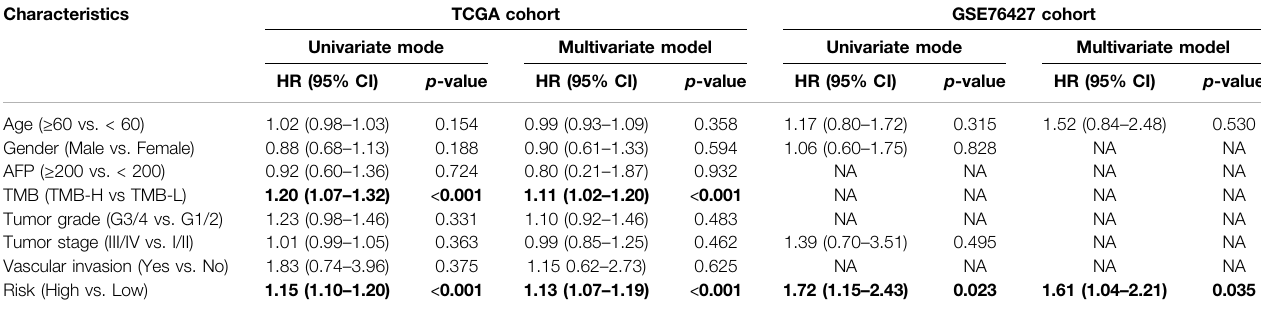
TABLE 3 | Univariate and multivariate Cox regression to identify independent prognosis predictor in both the TCGA cohort and the GSE76427 cohort. Characteristics